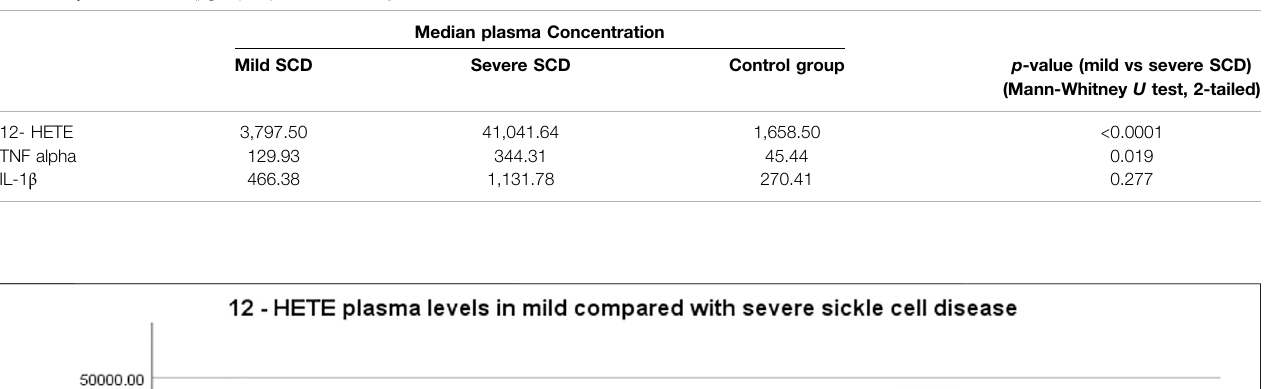
TABLE 2 | Plasma levels (pg/ml) of pro-in fl ammatory molecules in severe versus mild SCD.